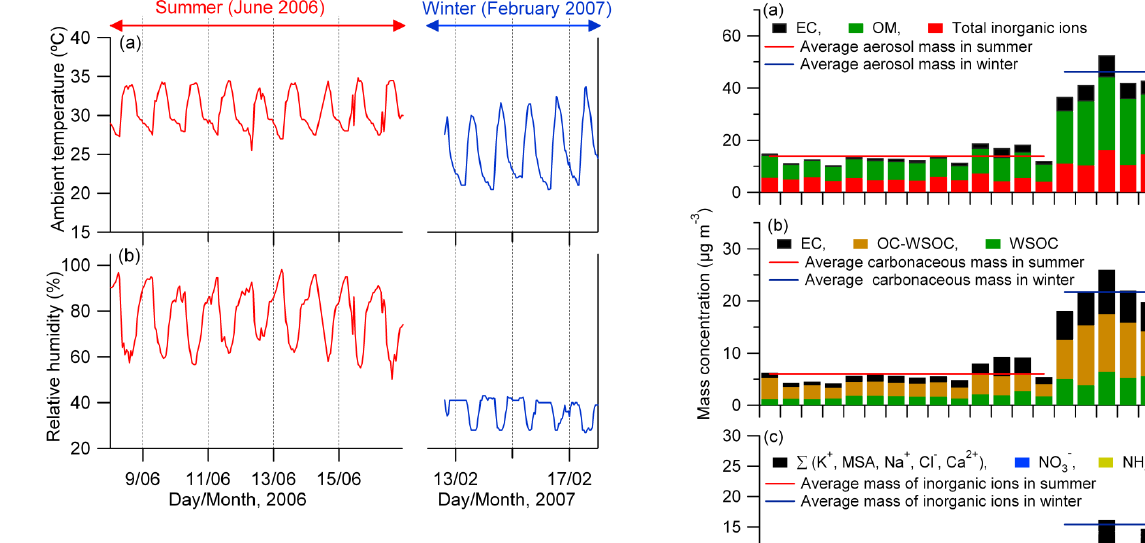
Fig. 1. Temperature and humidity recorded at the site during the campaign.